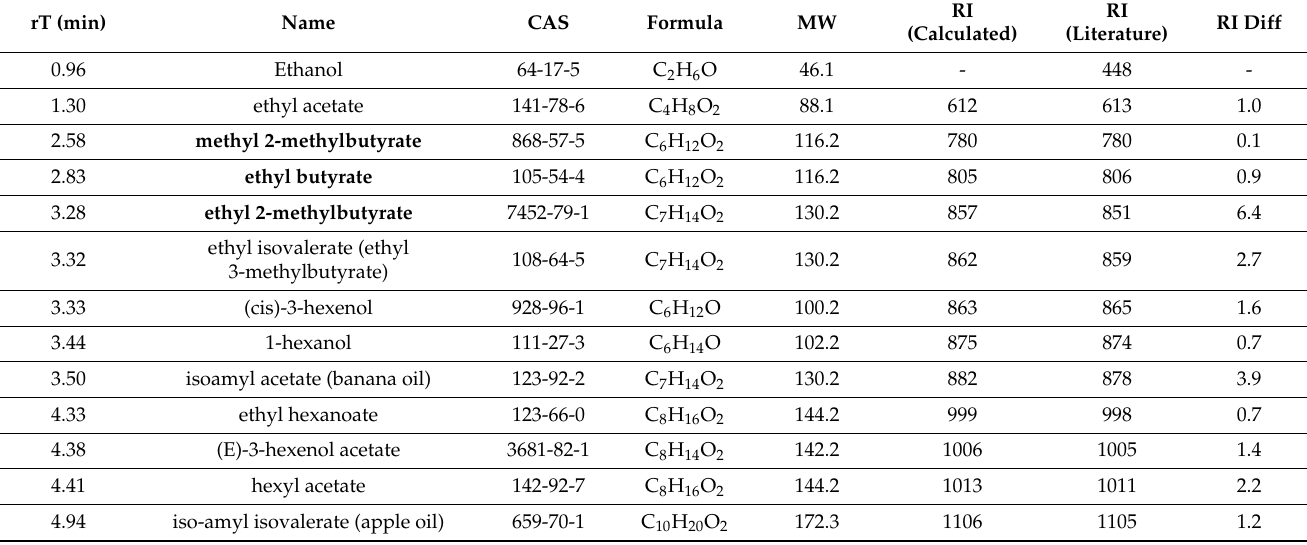
Table 4. List of strawberry aroma’s compounds.